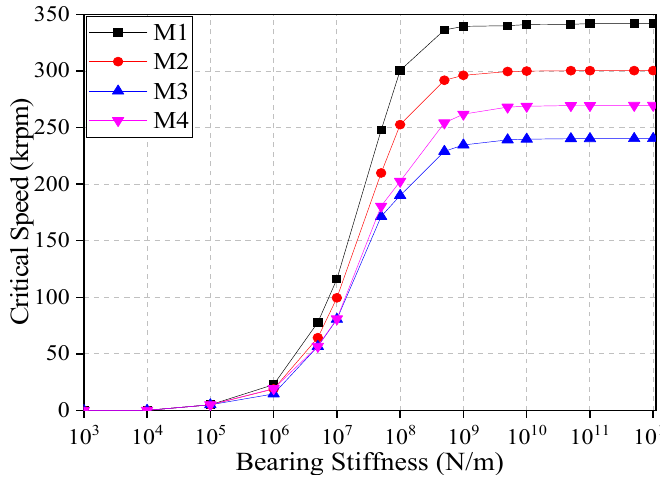
Figure 6. Influence of the critical speed on bearing stiffness.